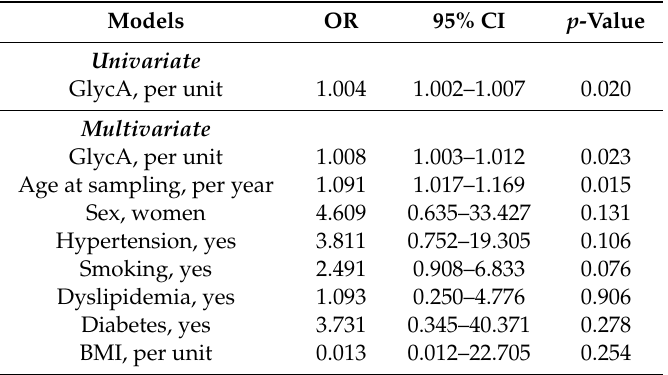
Table 3. GlycA as an independent predictor of subclinical CV disease in early RA.